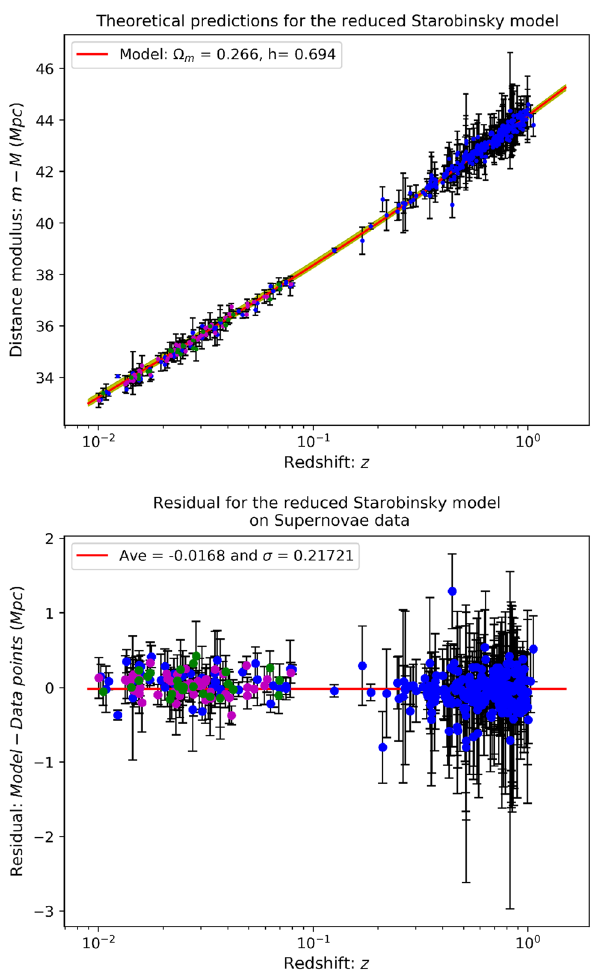
Fig. 8 The Hu–Sawicki model fitted to the Supernovae Type 1A data. With cosmological parameter values calculated by the MCMC sim- km km ulation as Ω m = 0 . 238 + 0 . 043 − (constrained), H 0 = 73 . 7 + 9 . 0 − (constrained), H 0 = 69 . 4 + 1 . 8 − 0 . 049 4 . 6 s . Mpc 0 . 024 0 . 6 s . Mpc (unreliably constrained), q 0 = − 0 . 486 + 0 . 300 − (unconstrained), and (unconstrained) 0 . 285 0 . 138 q 1 = − 0 . 036 + 1 . 018 − (unconstrained),whilethearbitraryfreeparameters 0 . 968 (constrained), β = 6 . 923 + 2 . 120 − were calculated to be α = 5 . 196 + 2 . 322 − 2 . 073 2 . 732 (unreliably constrained), and n = 2 . 262 + 0 . 800 − 0 . 724